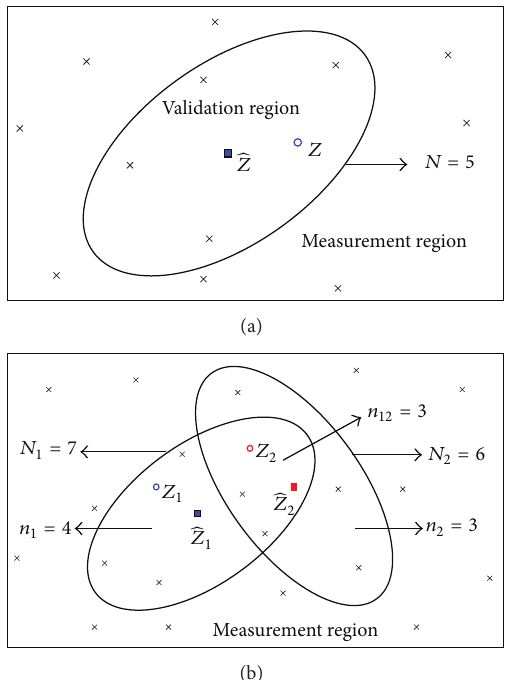
Figure 1: Examples of measurement validation region: (a) for a single target, (b) for two targets.